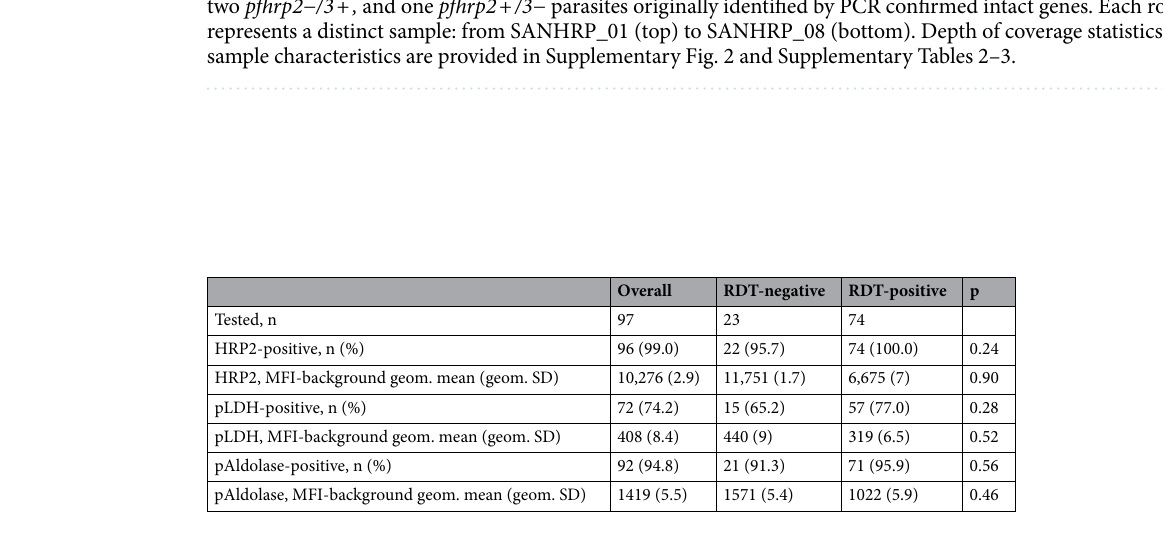
Table 2. Plasmodium antigen immunoassay results. Frequencies and log-transformed mean values were compared using the Fisher’s exact test and Kruskal–Wallis rank sum test, respectively. MFI-background values are visualized in Fig. 5. RDT rapid diagnostic test, MFI-background mean fluorescence intensity minus background, SD standard deviation.